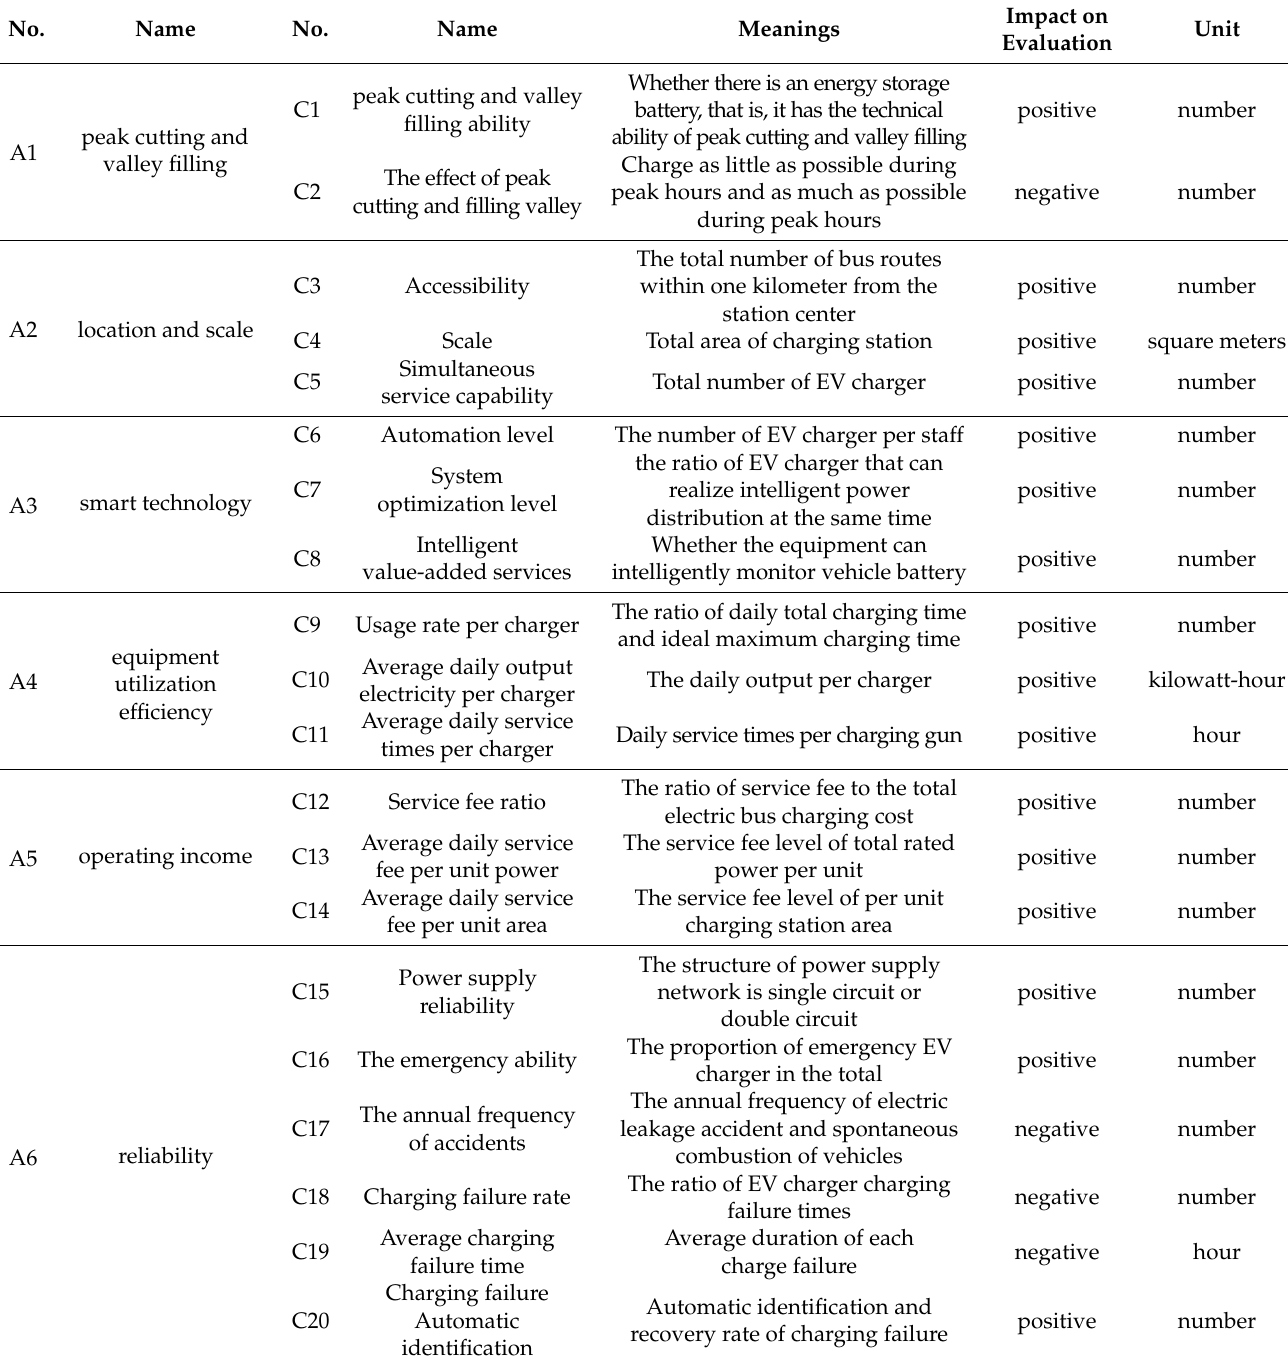
Table 4. The hierarchical structure of competitiveness evaluation